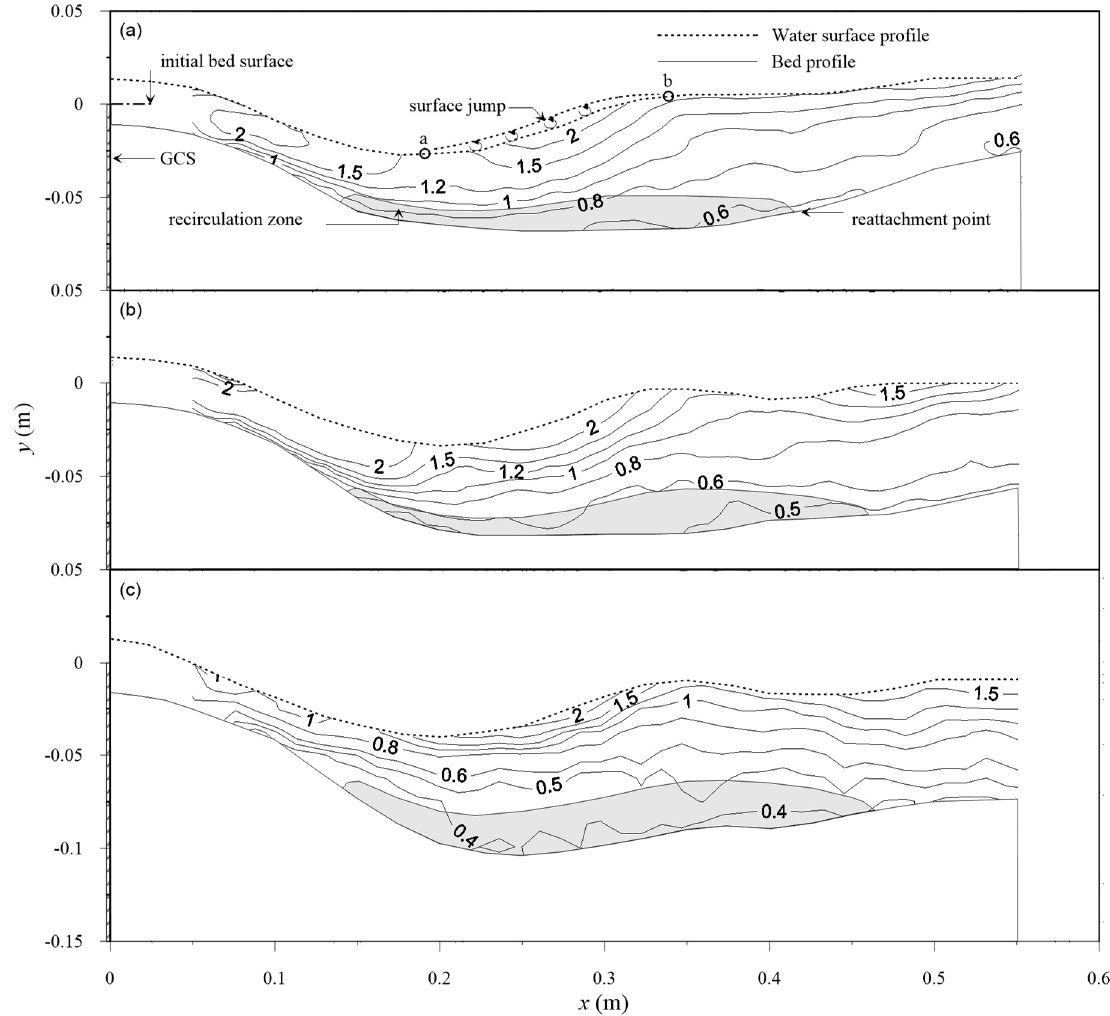
v ) contours in the scour hole *